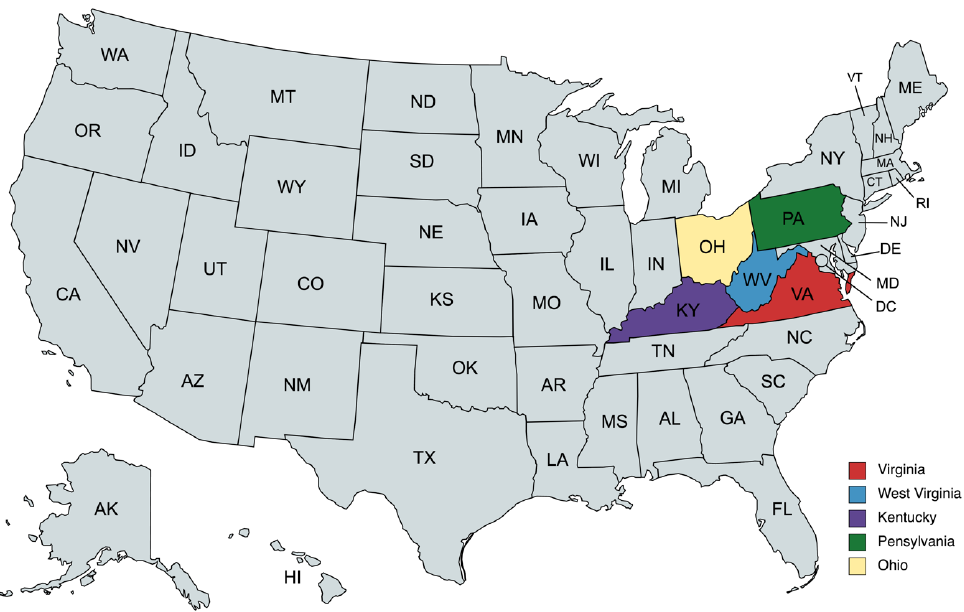
Figure 1. Location of the analyzed U.S. women’s population (map created with mapchart.net) .